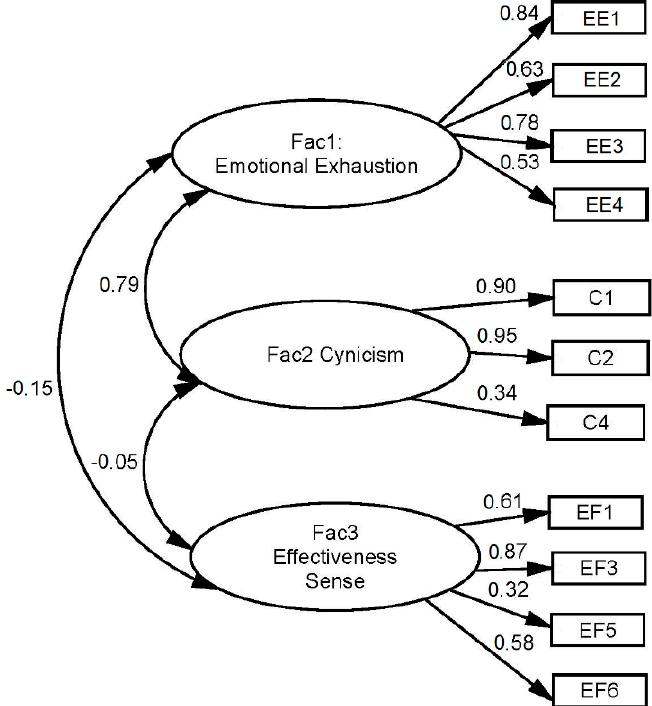
Figure 1. Confirmatory factor analysis of the MBI-GS instrument composed of the factors defined by the instrument and their covariance. The goodness of fit results allows confirmation of the structural validity of the instrument in the sample. Note: EE1, EE2, EE4; C1, C2, C4; EF1, EF3, EF5, EF6 respectively represent the items of the emotional exhaustion factor, cynicism factor, and effectiveness sense factor, of the MBI-GS instrument.